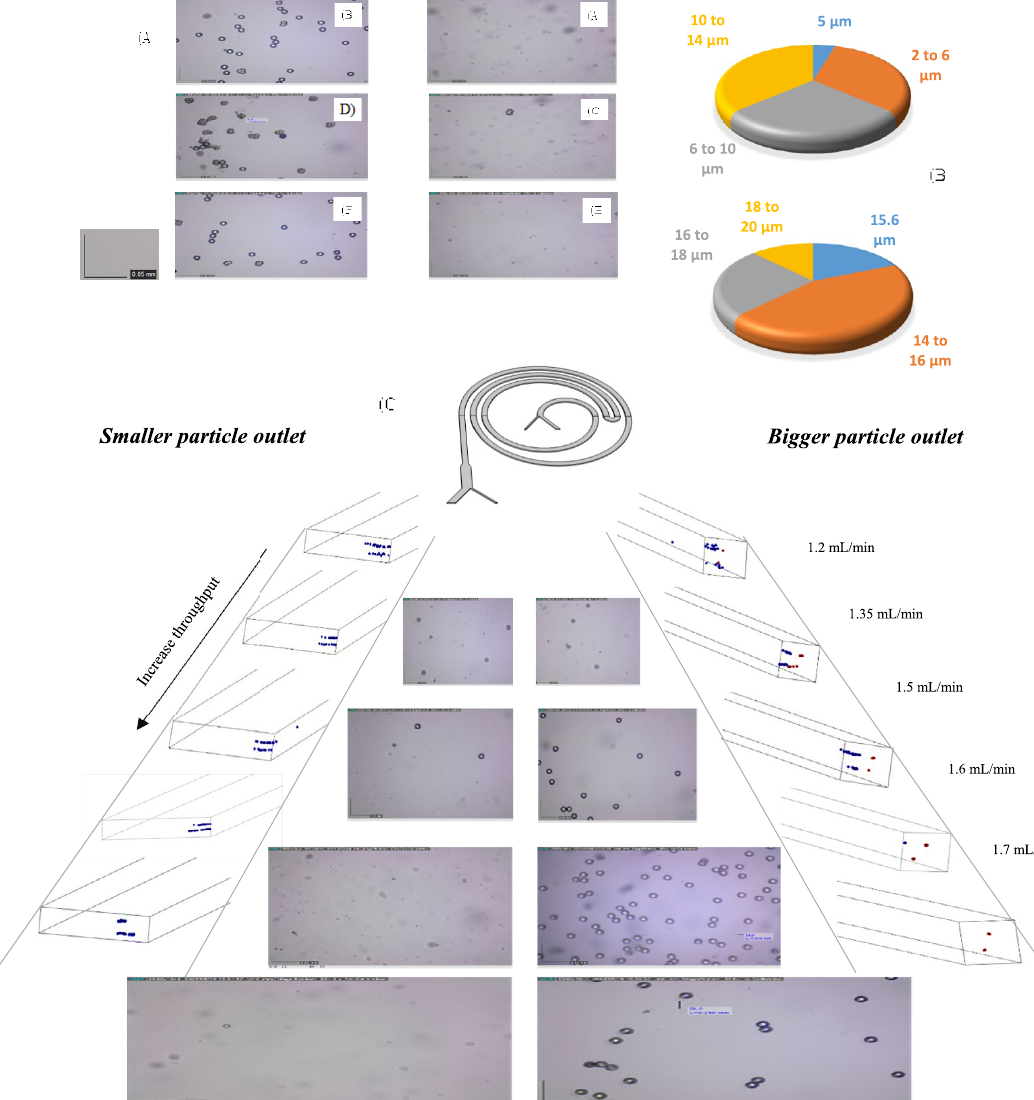
Figure 8. Simulation and experimental results for particles separation at different flow rates, In order to find the optimal flow rate, the flow rate is increased from 1 mL/min to 2 mL/min, the outlets are imaged and analyzed at each stage. ( A ) Experimental results for particles separation, ( A ) and ( B ) illustrated the desired outlets for smaller and bigger particles respectively at 1.4 mL/min. ( C – F ) Showed the same result at 1.55 mL/min and 1.7 respectively. The 1.7 mL/min result was better than other flow rates. ( B ) Indicate the size distributions of standard particles. ( C ) The optimum flow obtained by both simulation and experimental methods was approximately 1.7 mL/min. At this flow rate, more than 90% of smaller and bigger particles are